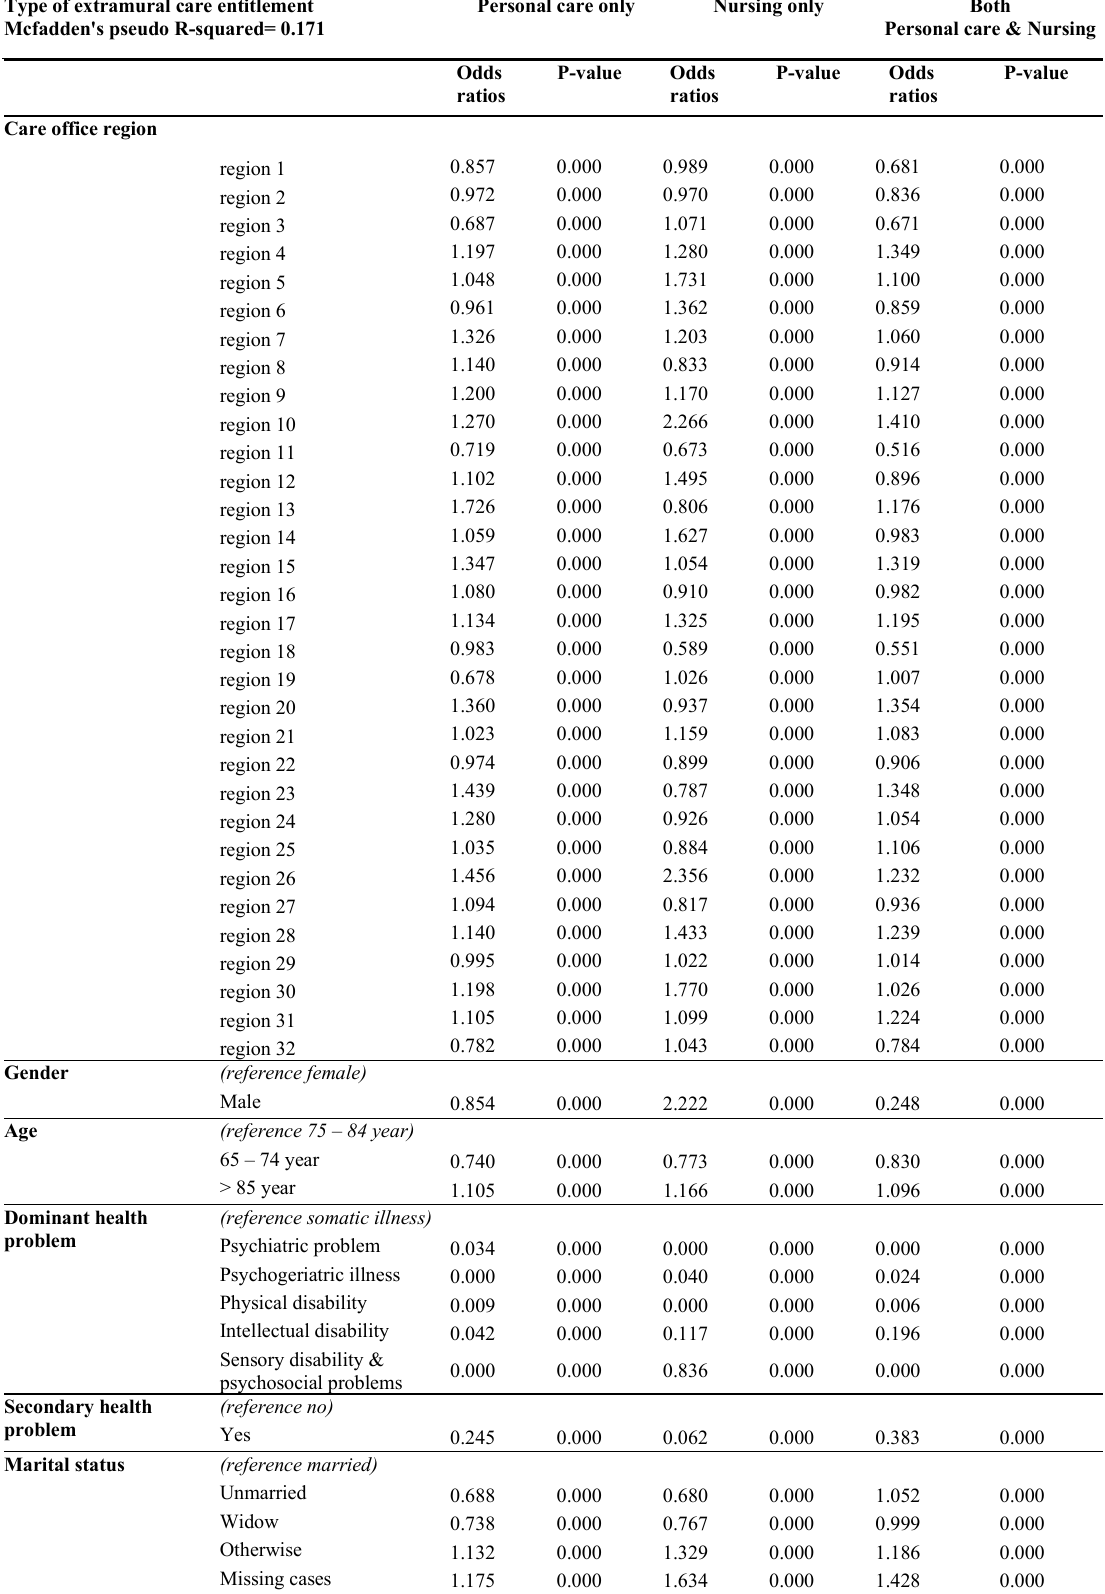
Table 3.1: Model 1 multinomial logistic model for the probability of an home care entitlement 65 and